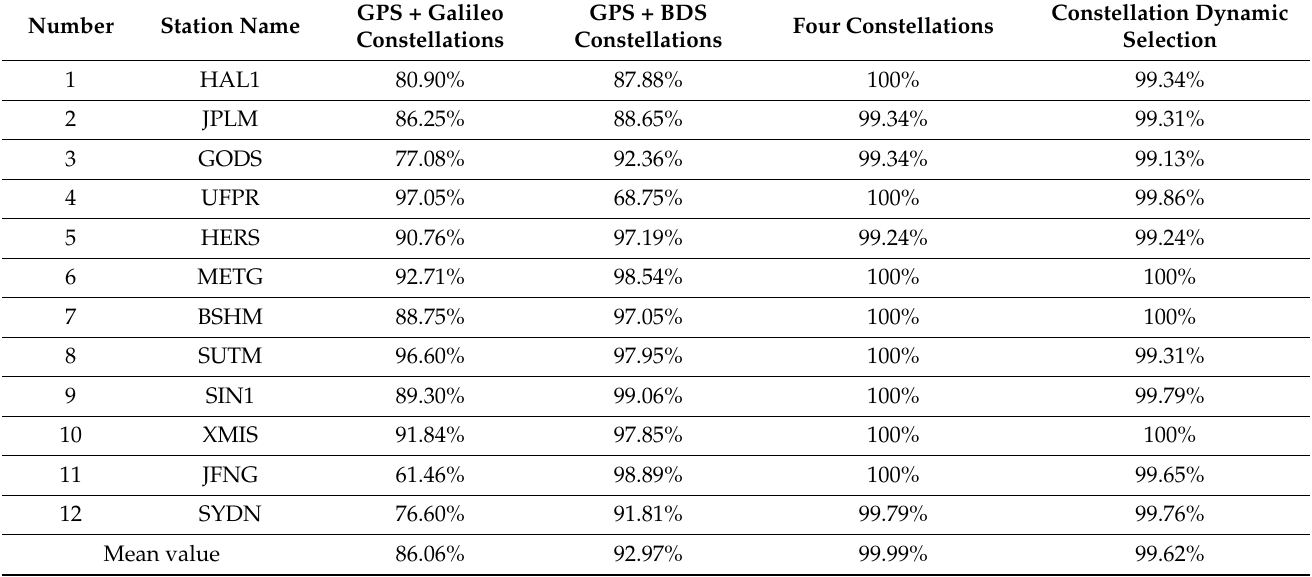
Table 5. ARAIM availability statistical results of observation